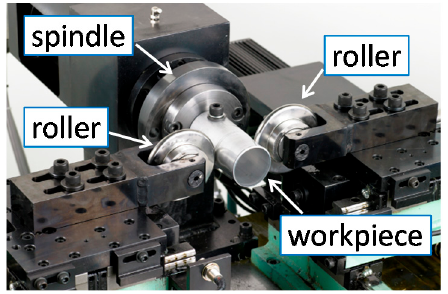
Figure 5. Five-axis two-roller CNC spinning machine.